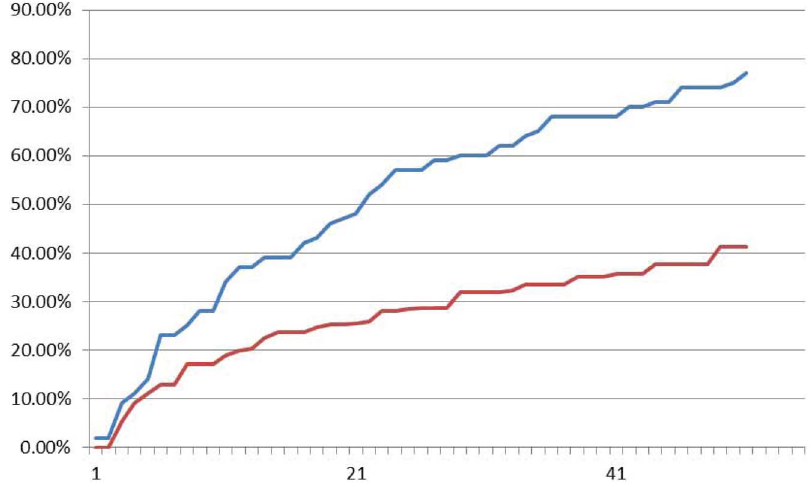
Figure 16. Fluoroscence data of DNA Neurons execute XOR logic with input ‘‘00’’. The X-axis is cycling time of Real-time PCR, the time span of each cycle is 10 minutes, temperature of each cycle keeps in 24–25 u C. The Y-axis is relative intensity of HEX (red curve) and FAM (blue curve).